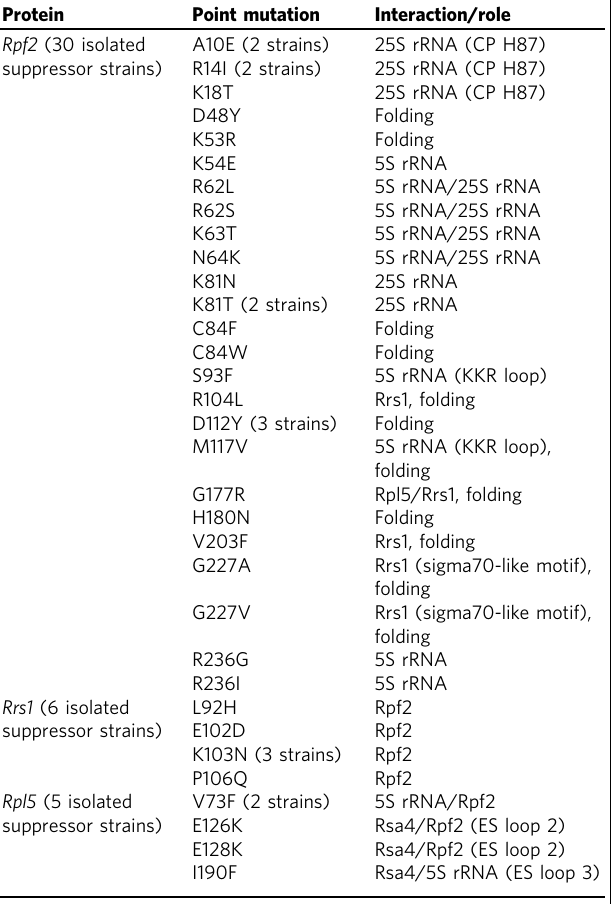
Table 1 Comparison of the isolated cgr1 Δ suppressor mutations Protein Point mutation